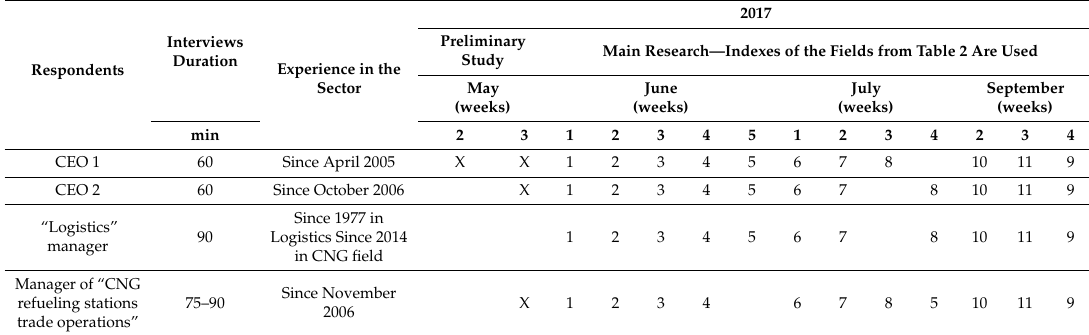
Table 3. Duration and respondents in the semi-structure